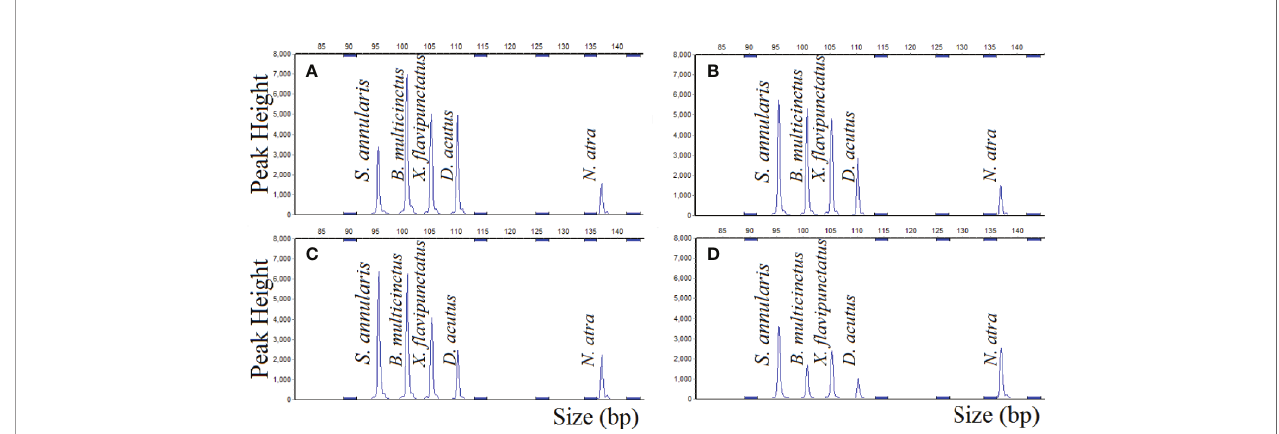
FIGURE 4 | MLPA method simultaneously identi fi es, differentiates, and relatively quanti fi es fi ve species (A) B. multicinctus accounts for 65%; (B) B. multicinctus accounts for 50%; (C) B. multicinctus DNA sample accounts for 30%; (D) B. multicinctus DNA sample accounts for